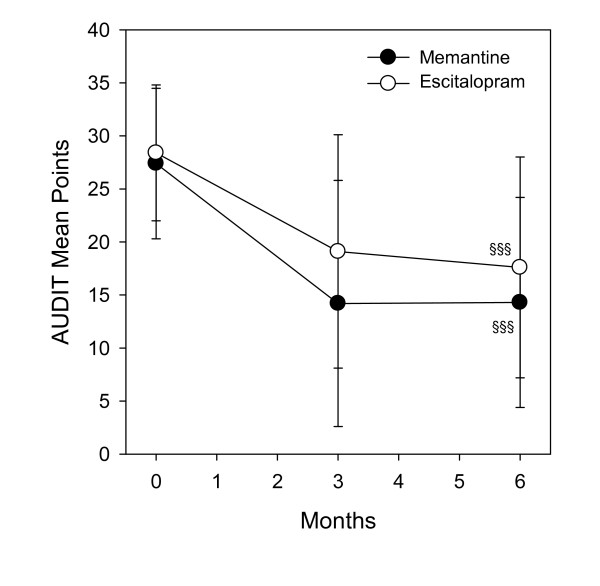
Change in alcohol use measured by the AUDIT scores. §§§Significant reduction from base values prior to treatment, p < .0001, ± SD.